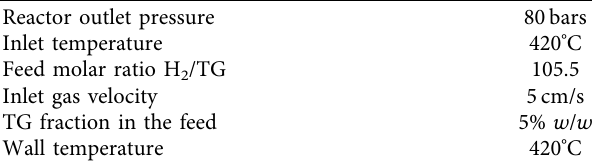
Table 4: Process parameters.